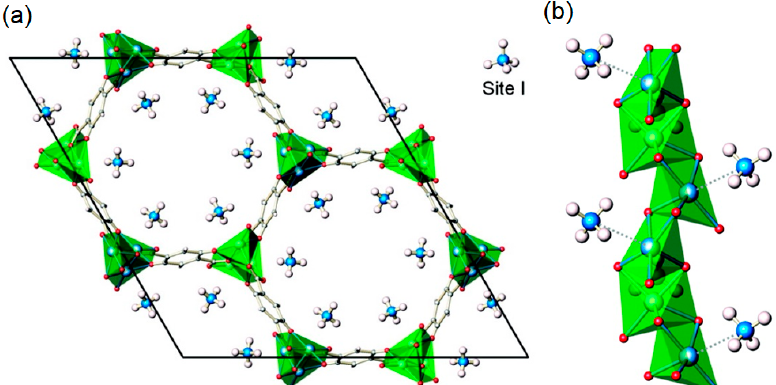
Figure 5. ( a ) M 2 (dhtp) (dhtp = 2,5-dihydroxyterephthalate) crystal unit cell with adsorbed CH 4 molecules on open metal site I. The location of sites was determined by neutron diffraction. ( b ) Metal oxide pyramids, organic linkers, and methane molecules. Adapted with permission from Ref. [136].